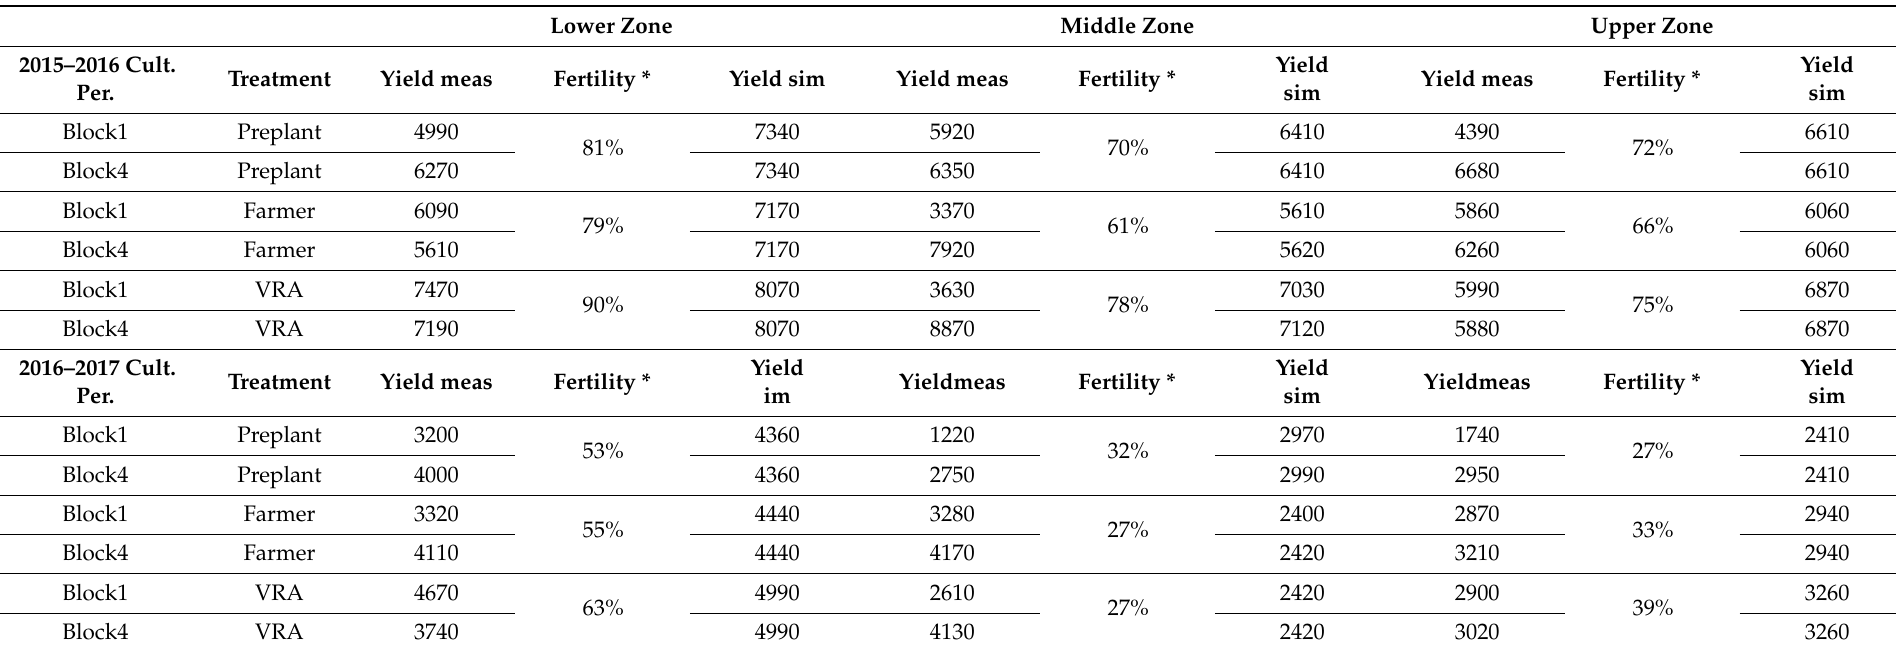
Table 7. Results of validation simulations (kg/ha) using average yearly fertility per treatment and zone (*) obtained in the calibration stage (Blocks 1 and 4). Lower Zone Middle Zone Upper